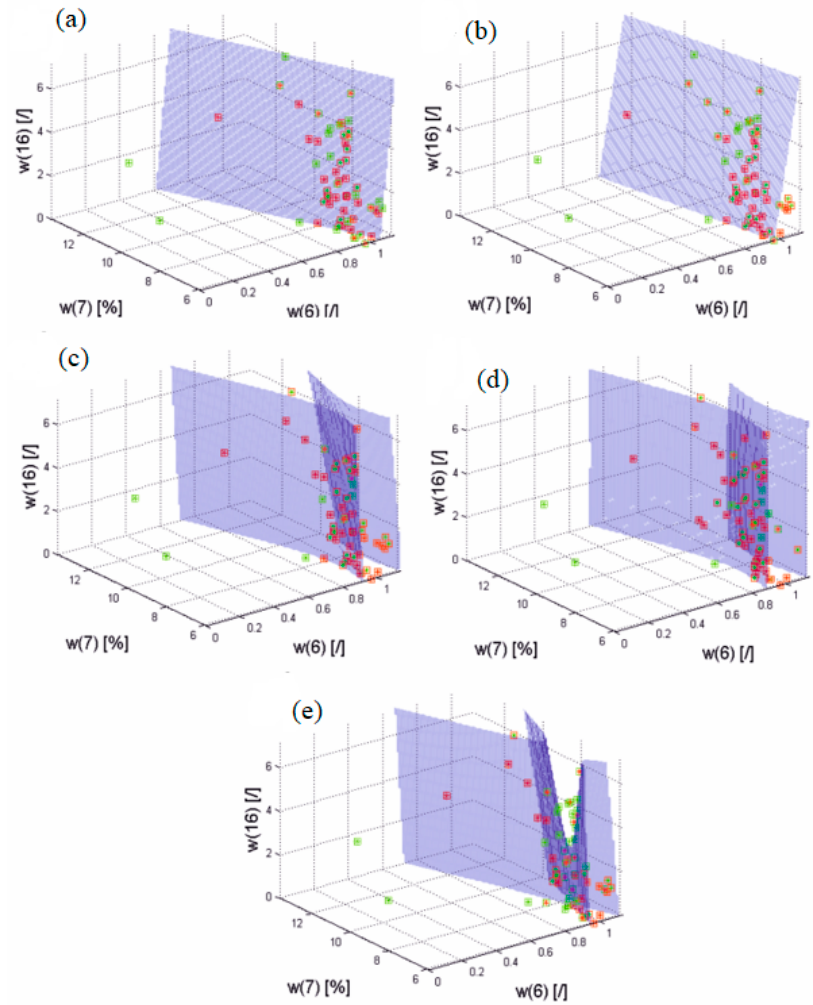
Figure 3. Diagrams of changes of parameters Δ w (6), Δ w (7) and Δ w (16) together with discriminant functions for five considered cases: ( a ) linear, ( b ) diaglinear, ( c ) quadratic, ( d ) diagquadratic, and ( e ) mahalonobis. Red marks the values of parameters before pharmacological treatment, while green marks the period of six months after treatment. A green star with a red border, and vice versa, mark false cases (false positive and false negative, respectively).